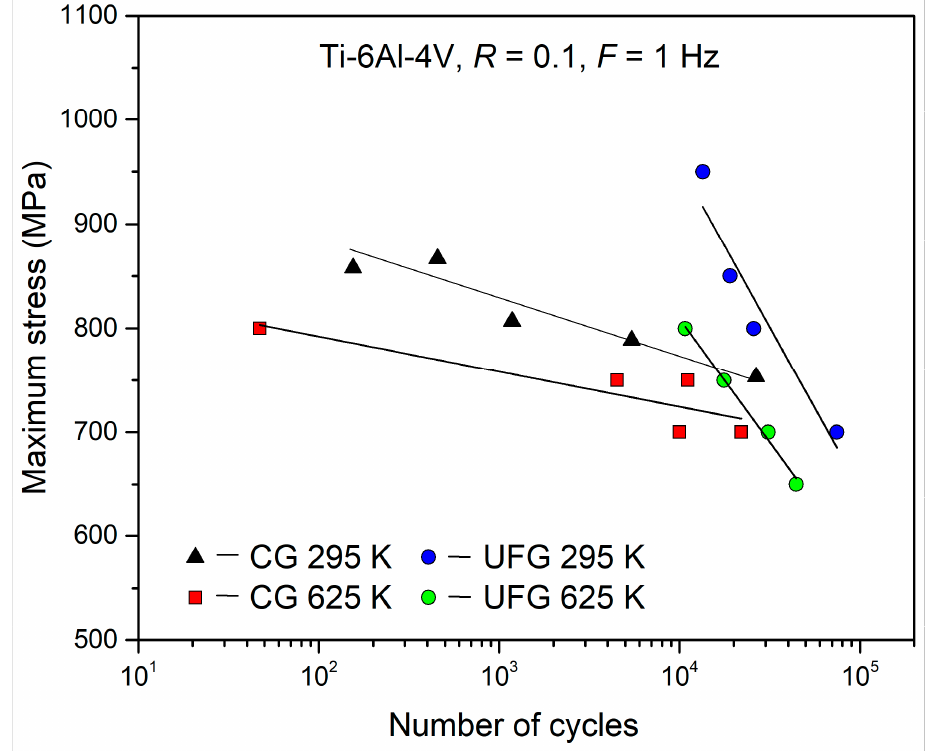
Figure 5. Number of cycles to failure versus maximum stress for the CG and UFG Ti-6Al-4V alloys. The fatigue resistance decreases for both SC and UFG states at T = 625 K (Figure